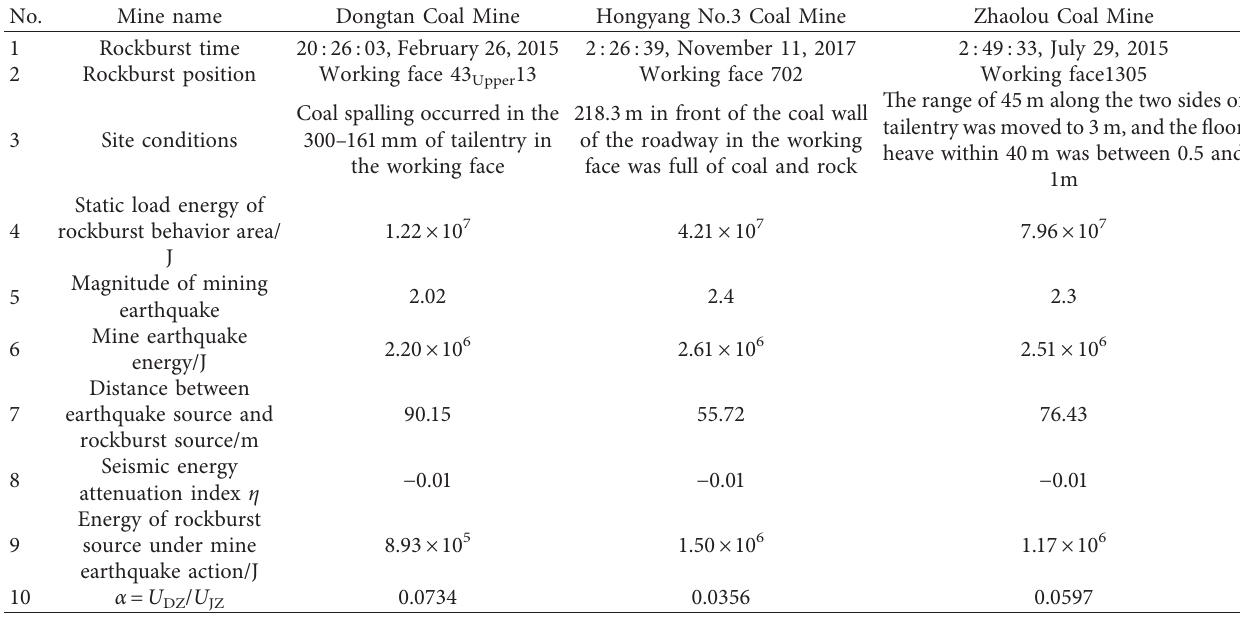
Table 1: Calculation process and results.